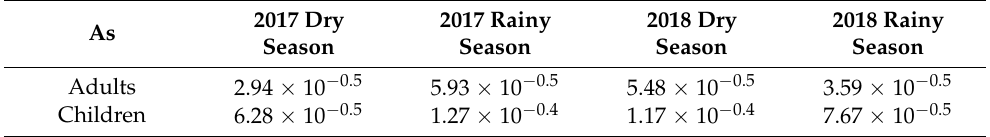
Table 5. Summary of data for As.